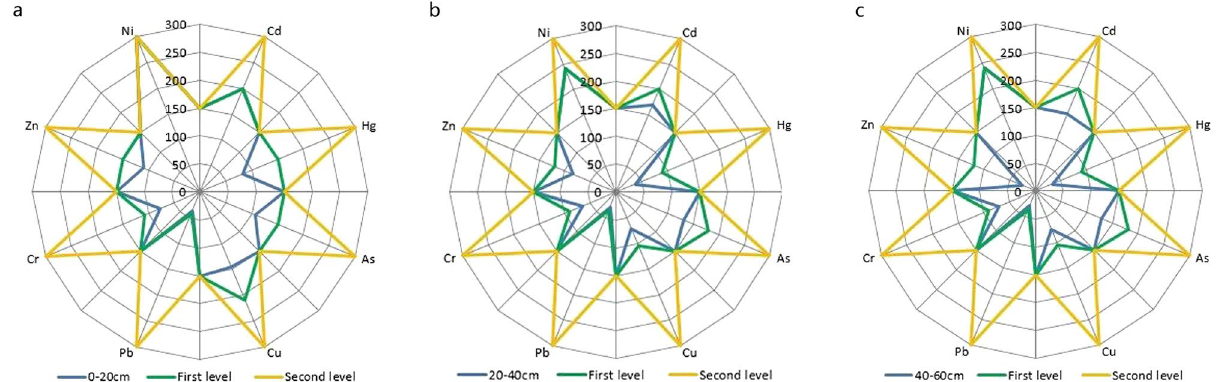
Figure 3. Environmental quality equal intercept transformation radar chart of the soil in the plain area.